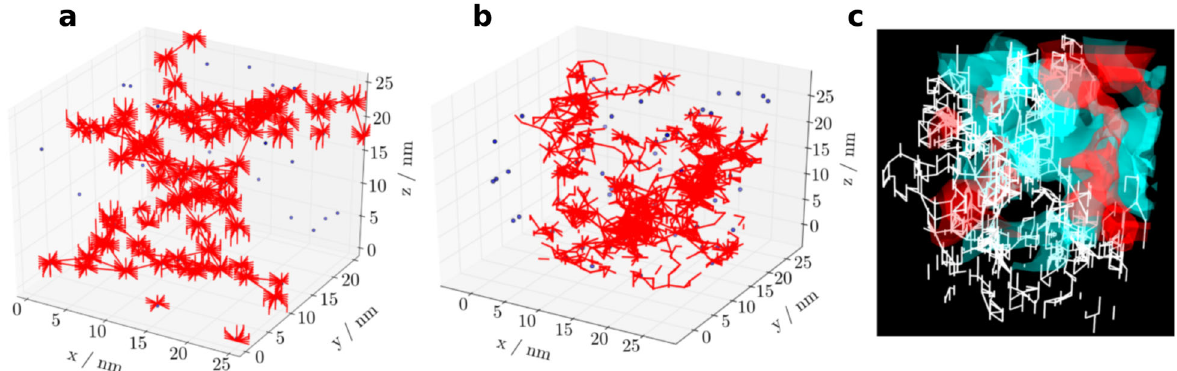
Fig. 3 Exemplary critical subnetworks without and with intrinsic energetic disorder at low and high doping ratios. for F 8 ZnPc (see Supplementary Note 2 for parameter information). Blue dots represent the ionized dopant positions. In panels a and b , a low doping ratio of 0.32% is present. In the case of no energetic disorder a , the network consist of bunches of short transitions (which contribute almost nothing to global transport) in the vicinity of dopants and long transitions between the dopants. These long transitions are critical for the global conductivity. When intrinsic energetic disorder of σ 0 = 120 meV is introduced b , the long transitions can be broken into several shorter ones, as some sites are randomly energetically lowered by the disorder. They can thus serve as bridging sites between the dopants and E A is reduced compared to the disorder-free case. c Shows a high doping ratio of 32%. The white lines represent the critical subnetwork in a 3D contour plot of the calculated bulk potential. Note that the critical subnetwork paths avoid regions of both high (red, where they are repelled) and low (cyan, where they would be bound) potential and mainly occupy potential-free regions. Charge carriers have to circumnavigate the regions of strong potential to traverse the sample, which increases E A at very high concentrations.